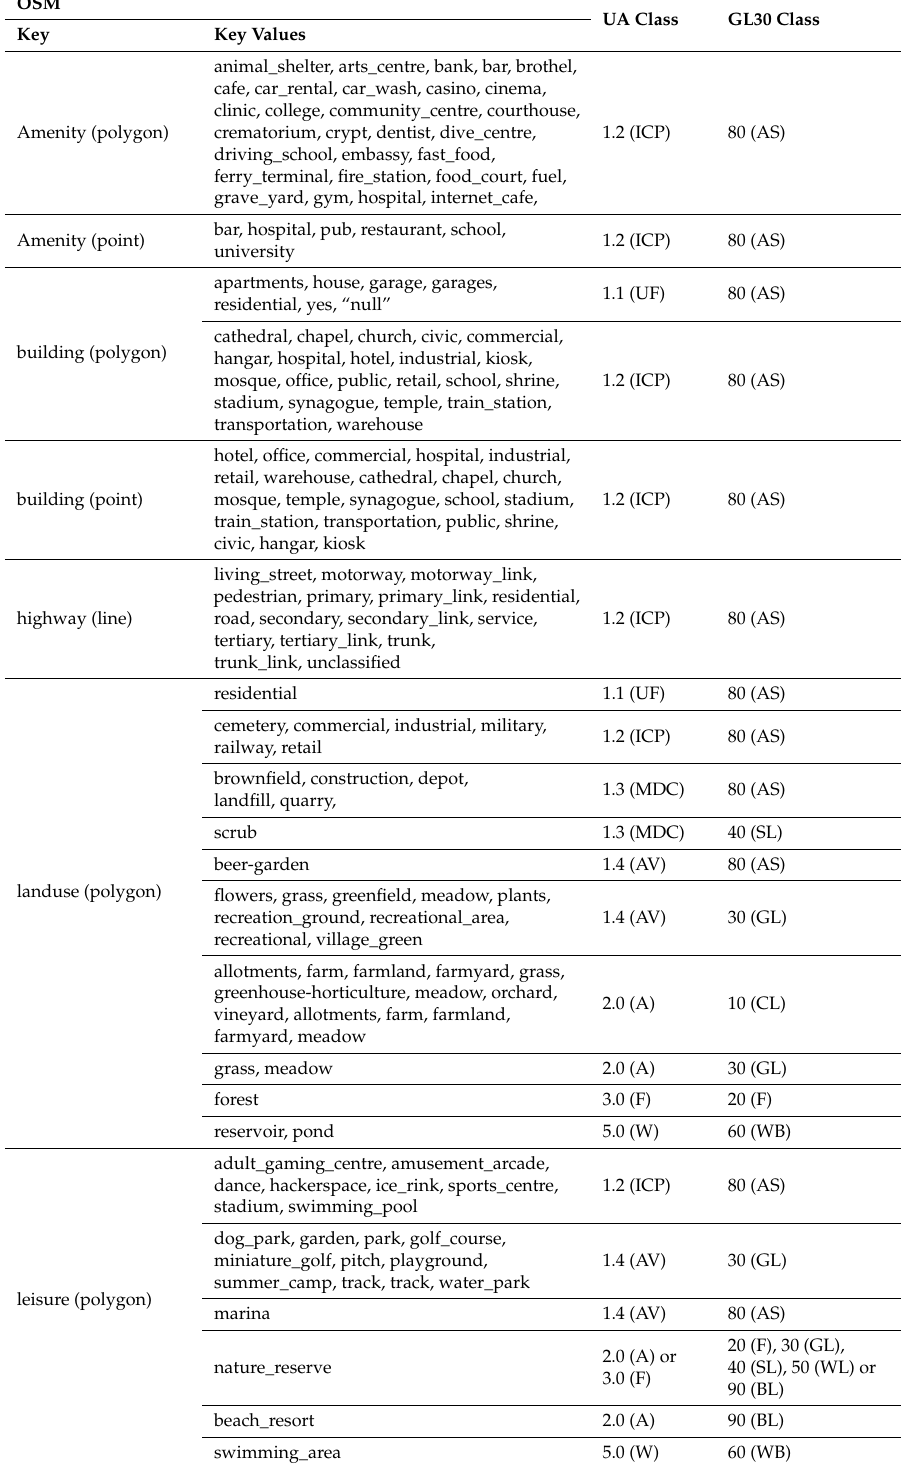
Table 3. Combined nomenclature of UA and